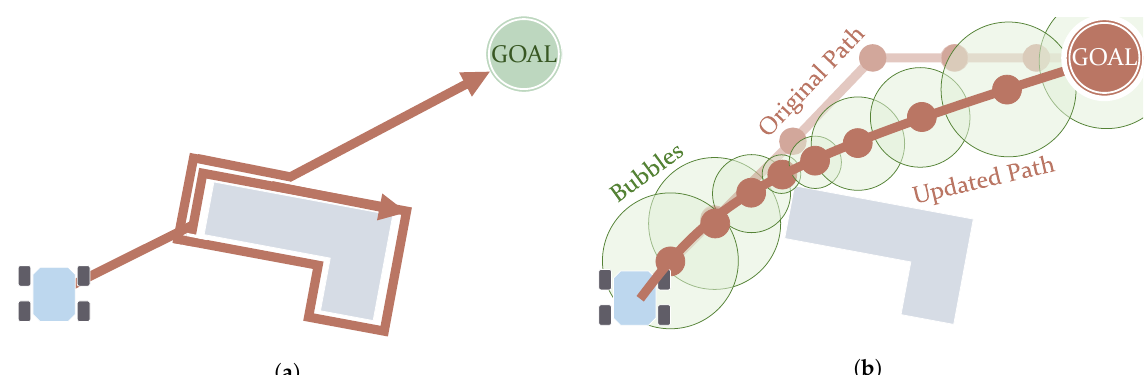
Figure 6. Graphical representations of concepts used in the Bug algorithm ( a ) and Elastic Bands ( b ) algorithm with Bubble bounds. ( a ) Path after using the Bug1 algorithm. ( b ) Path after experiencing